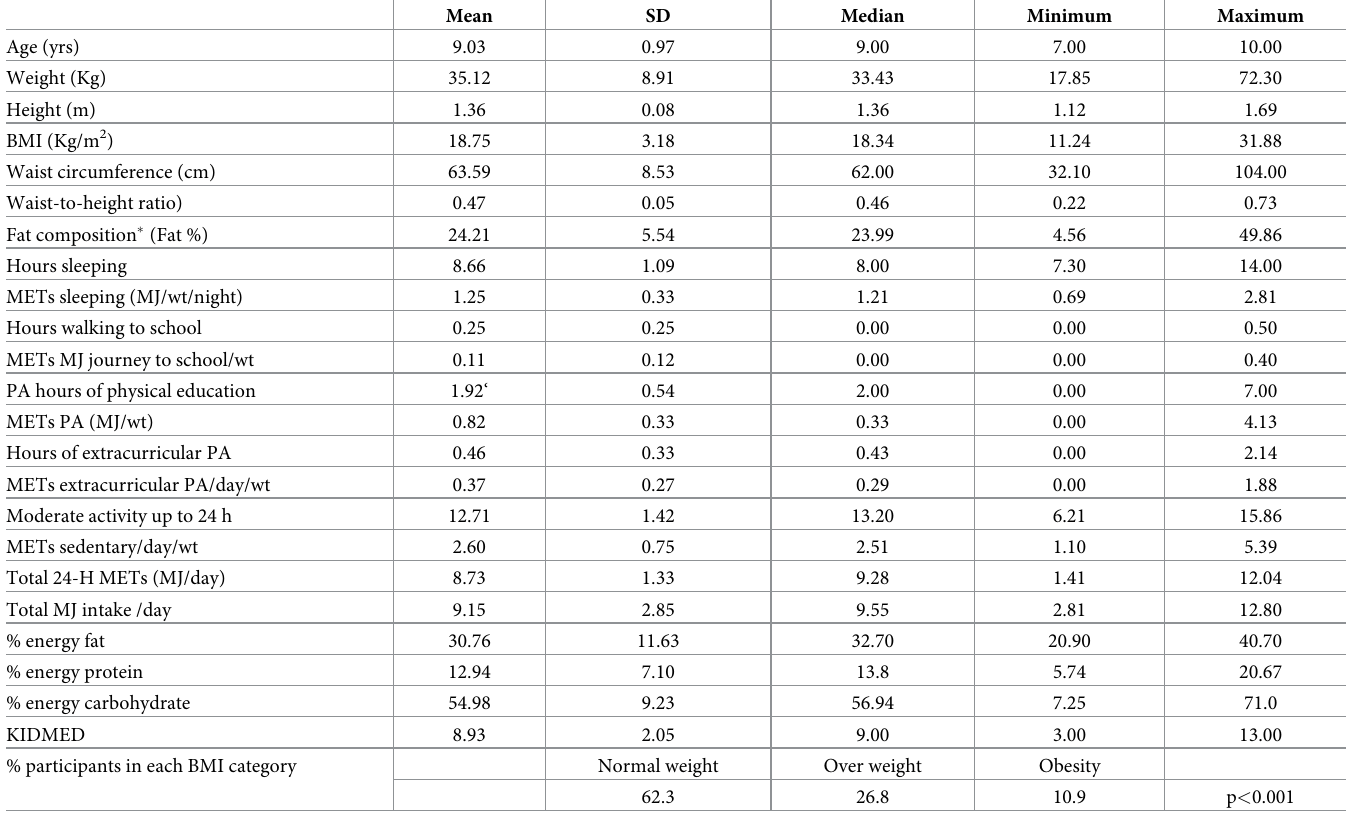
Table 1. Population